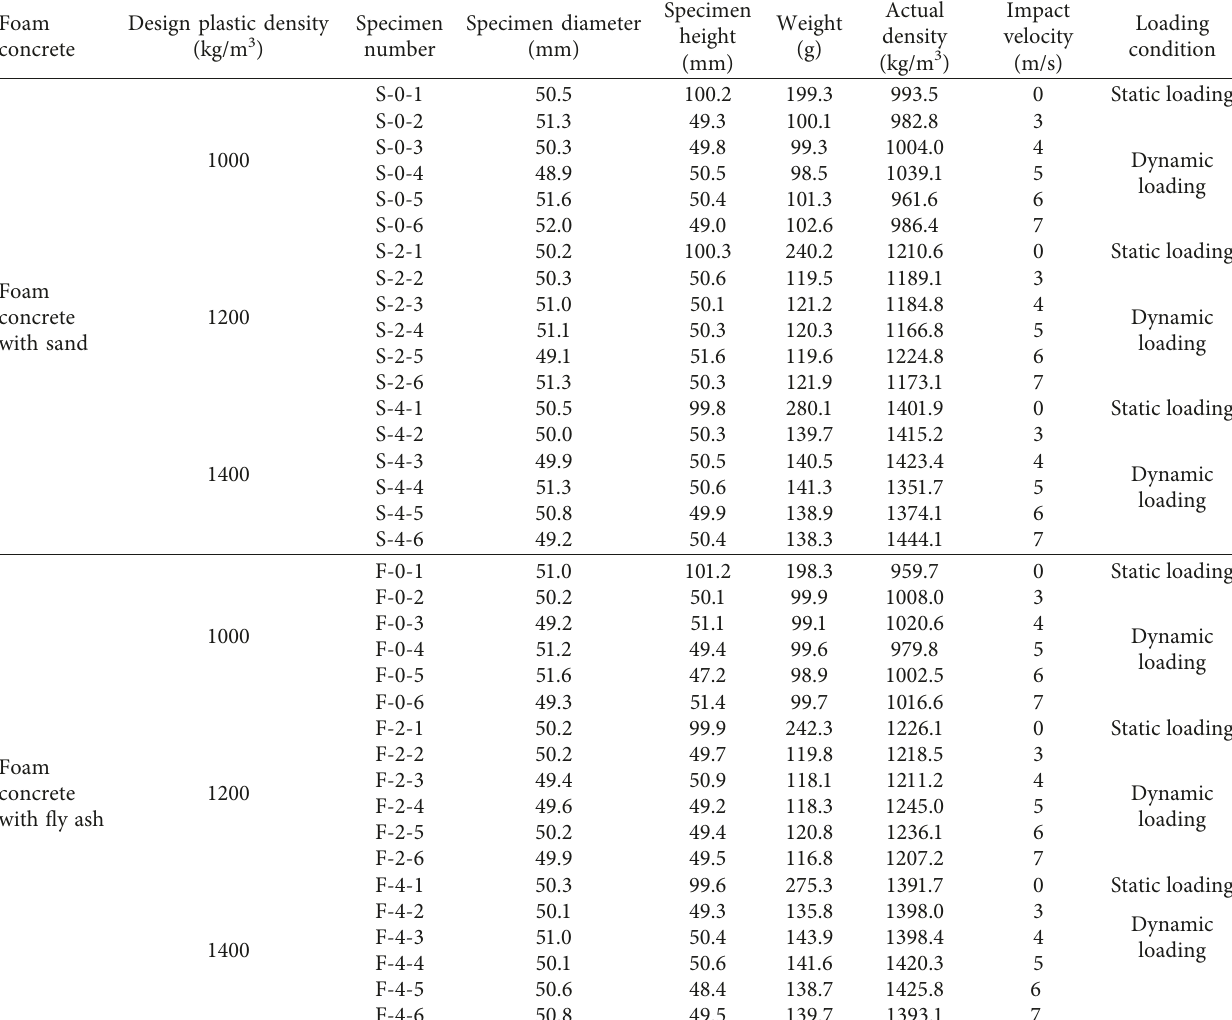
Table 3: Design density and actual density of each tested